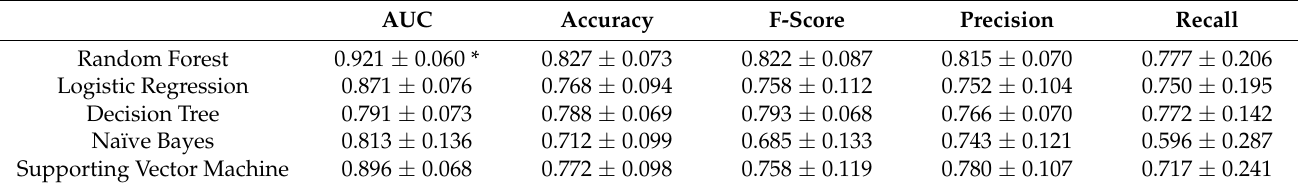
Figure 2. Spatial illustration of key mutation sites. The 3D structure of reverse transcriptase is labeled in blue. Ligand-binding sites predicted by POCASA are labeled as yellow balls, and the 47 key mutation sites in this model are colored as red balls. Table 1. The model performance of 10-fold cross-validation using different machine learning approaches on training